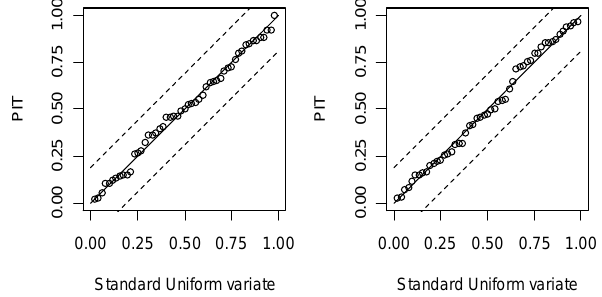
Figure 5: PIT uniform probability plots of post-processed streamflow predictions for two months 493 Fig. 5. PIT uniform probability plots of post-processed stream- (Feb. and Jul) in Lake Eildon; (1:1 solid line, theoretical uniform distribution; broken lines, 494 flow predictions for two months (February and July) in Lake Eil- Kolmogorov 5% significance band; circle, PIT value of observed streamflow). 495 don (1 : 1 solid line, theoretical uniform distribution; broken lines, Kolmogorov 5% significance band; circle, PIT value of observed streamflow).